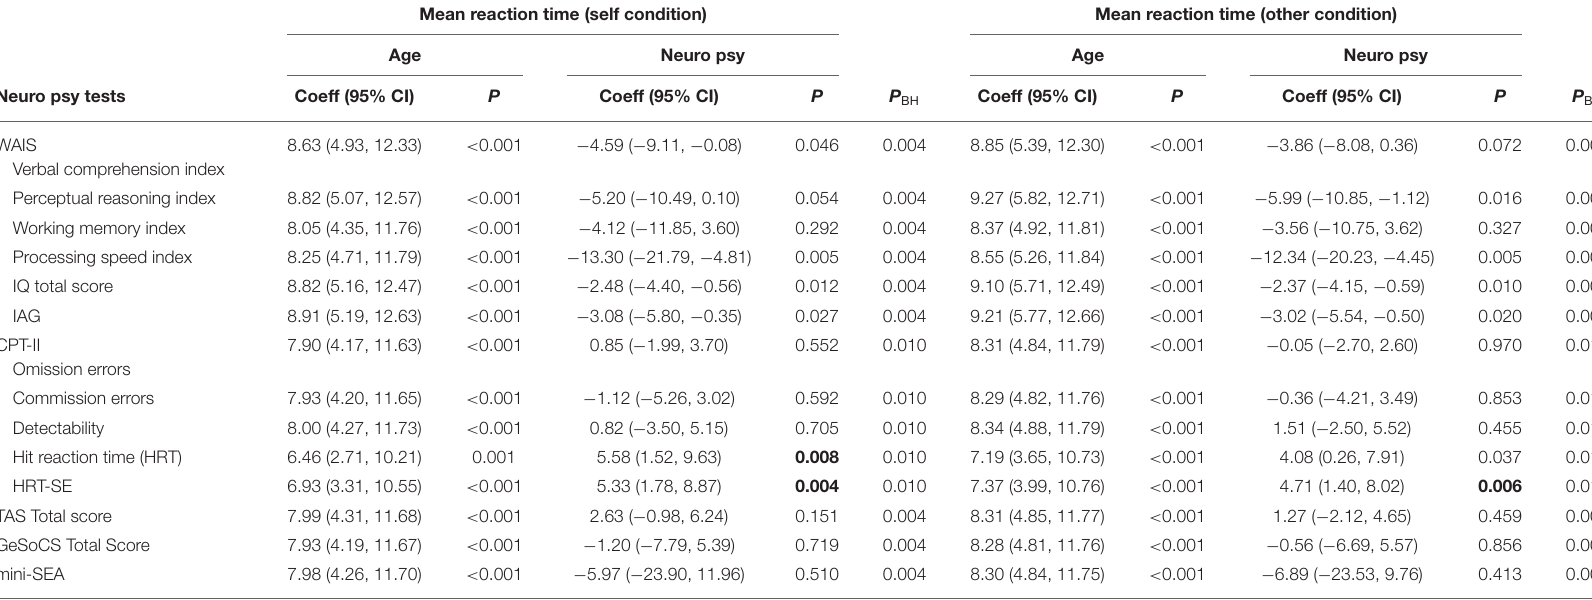
TABLE 2 | Association of neuropsychological tests (independent variables) with mean reaction time using linear regressions, adjusted for age. Mean reaction time (self condition) Mean reaction time (other condition) Age Neuro